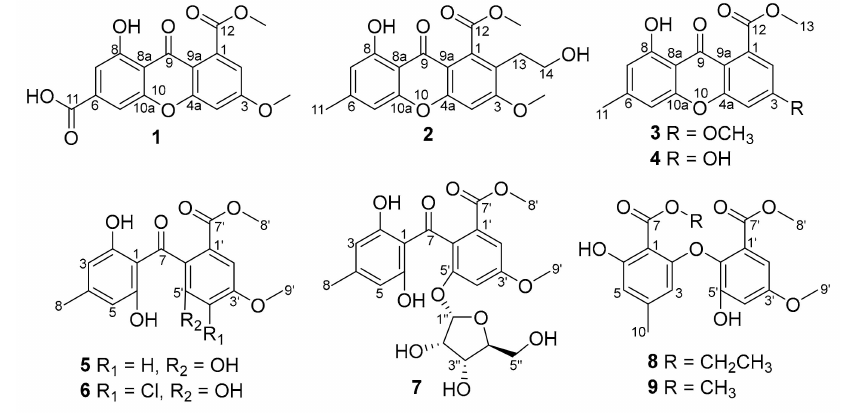
Figure 1. Chemical structures of compounds 1 – 9